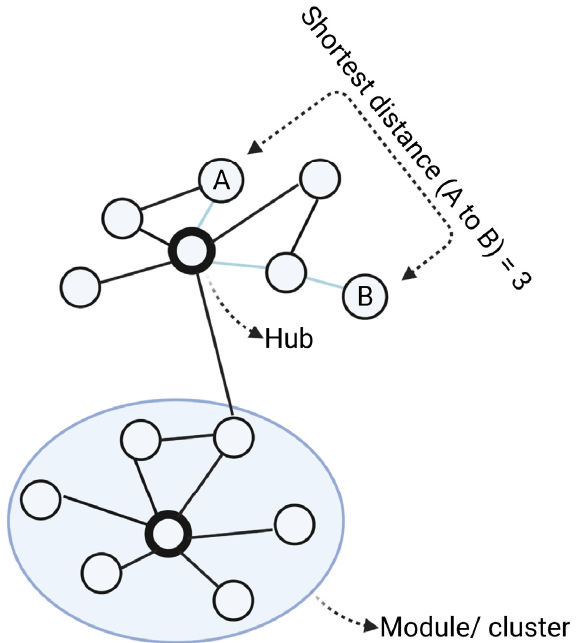
Figure 2. Main elements of a network. In the network, nodes (circles) are connected via edges (lines). For biological networks, nodes are usually biological entities (genes, proteins) and edges denote their relationships (interaction, association, similarity). From the networks, modules are clusters of closely connected nodes. Degree is the number of direct connections a node has to other nodes. Hubs are nodes with the highest degrees in the networks, meaning they have the highest number of connections. The shortest distance between node A and B is the path with the minimum number of edges from A to B. Created with BioRender.com (accessed on 2 June 2022). Network-based drug repurposing efforts are generally based on Swanson’s ABC model to retrieve unknown latent knowledge from multiple sources of data incorporated in the networks [46]. An assumption of this approach is that when term A is connected to term B, and term B is connected to term C, we can assume that terms A and C are also connected. For example, an indirect link between drug and disease can be inferred from a direct drug-target connection and a direct target-disease connection. In the ABC model, A and C must originate from different domains to yield new knowledge, and B can include multiple steps to abridge from A to C (A B 1 B 2 … B n C) [47,48] (Figure 3).